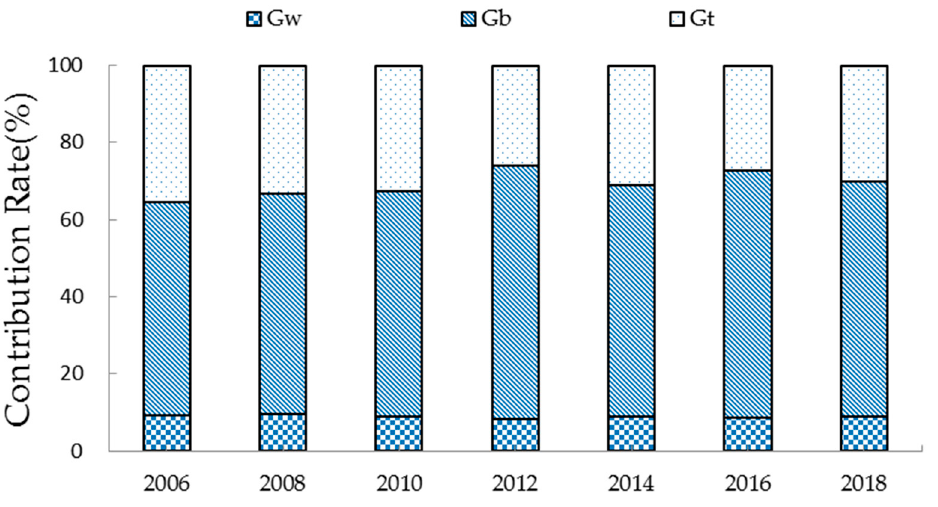
Figure 4. Sources of spatial differences in China’s EWP.